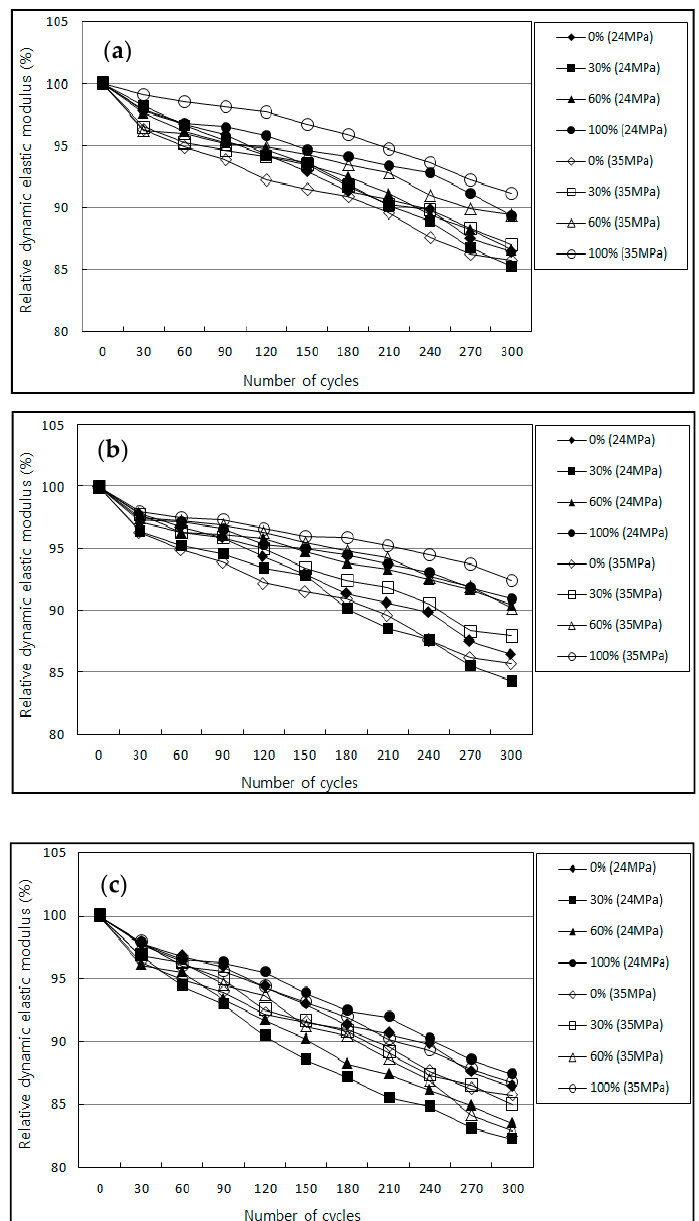
Figure 12. Relative dynamic elastic modulus and number of cycles: ( a ) Recycled coarse aggregate replacement, ( b ) recycled fine aggregate before modification, and ( c ) recycled fine aggregate after modification.